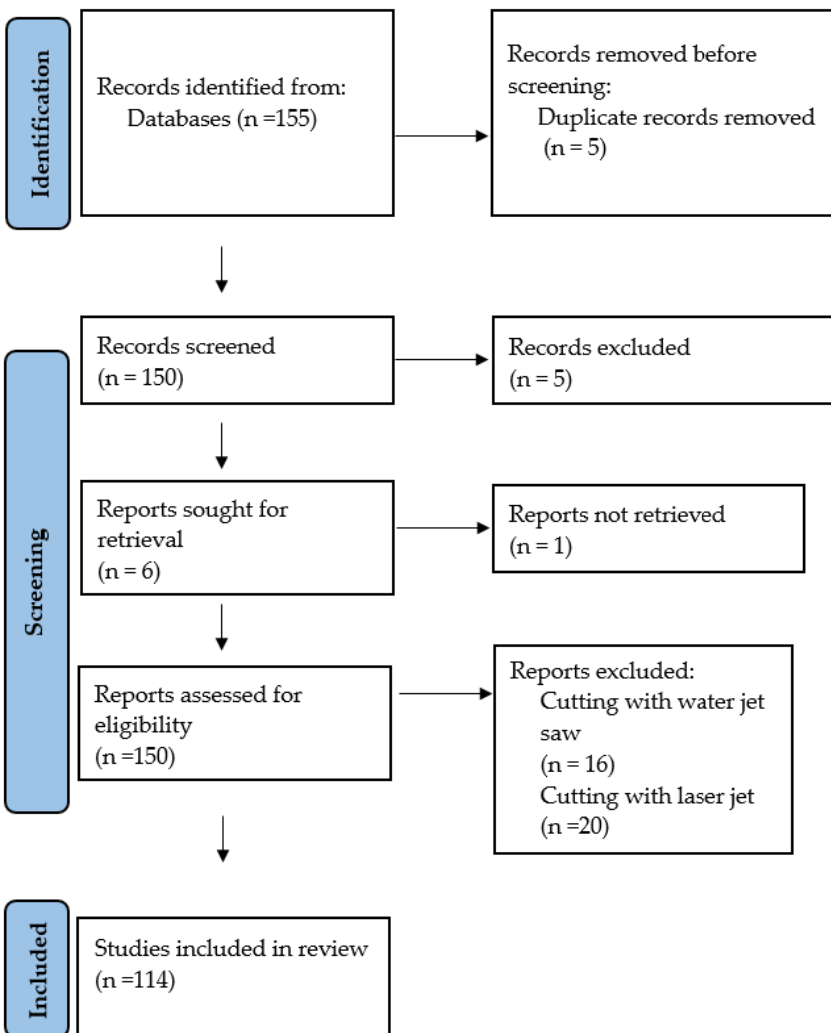
Figure 2 . Search process and results, adapted from PRISMA [14]. Figure 2. Search process and results, adapted from PRISMA